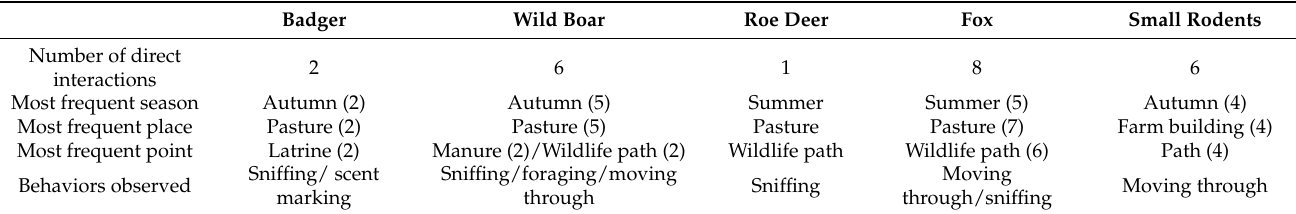
Figure 2. Percentage of the occurrence of each behaviour exhibited per species. Table 4. Description of direct contacts between wild mammals and